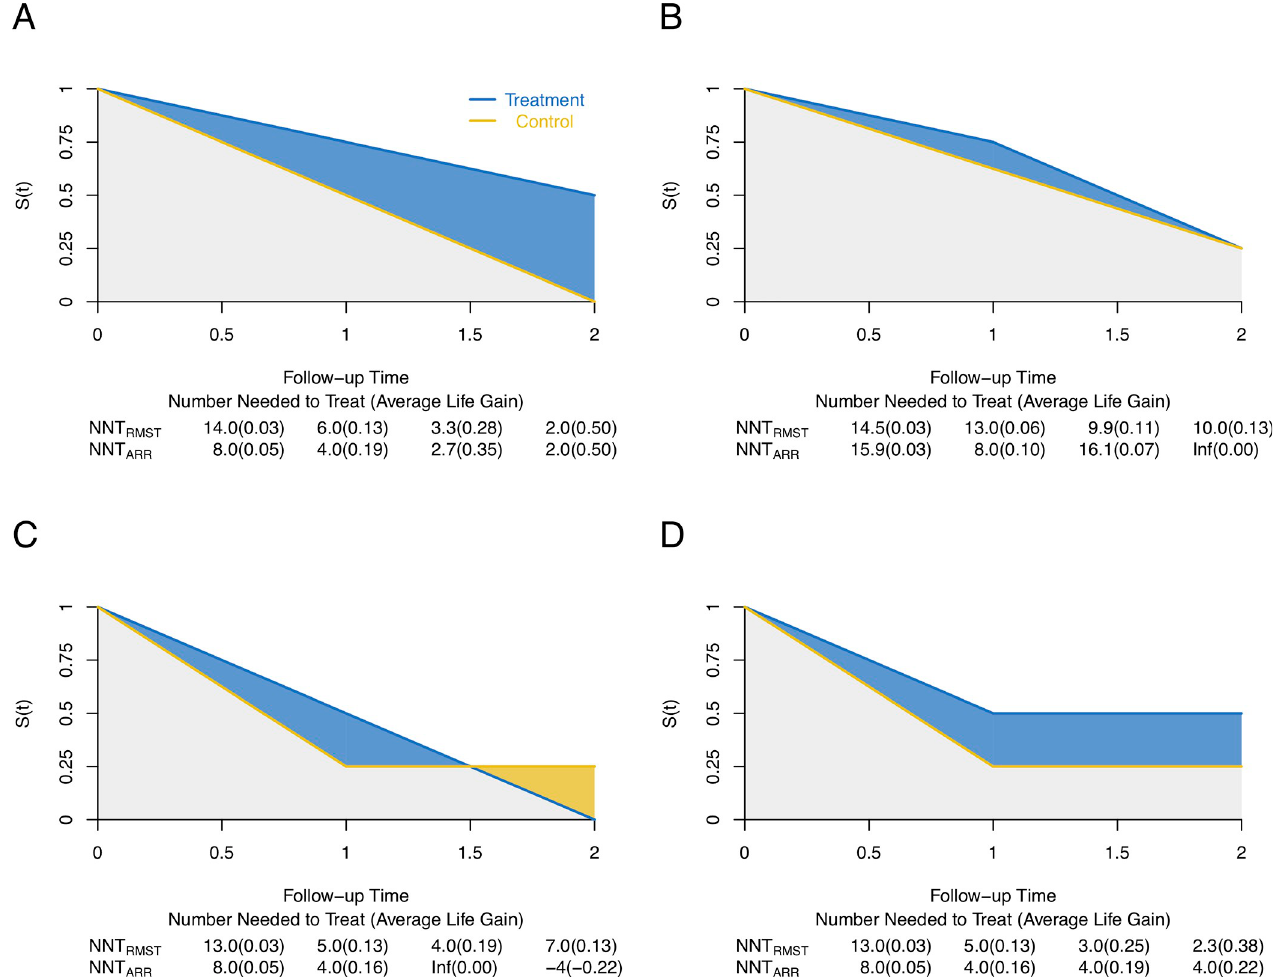
Fig 4. Hypothetical examples representing four different scenarios. (A) Scenario 1: Survival curves with an increasing treatment effect over time. (B) Scenario 2: Survival curves converge at the end of the follow-up. (C) Scenario 3: Survival curves cross during the follow-up period. (D) Scenario 4: Survival curves with a mixture of short- and long- term effects. The area up to time t under each scenario between treatment and control groups represent the average life gain (ALG).